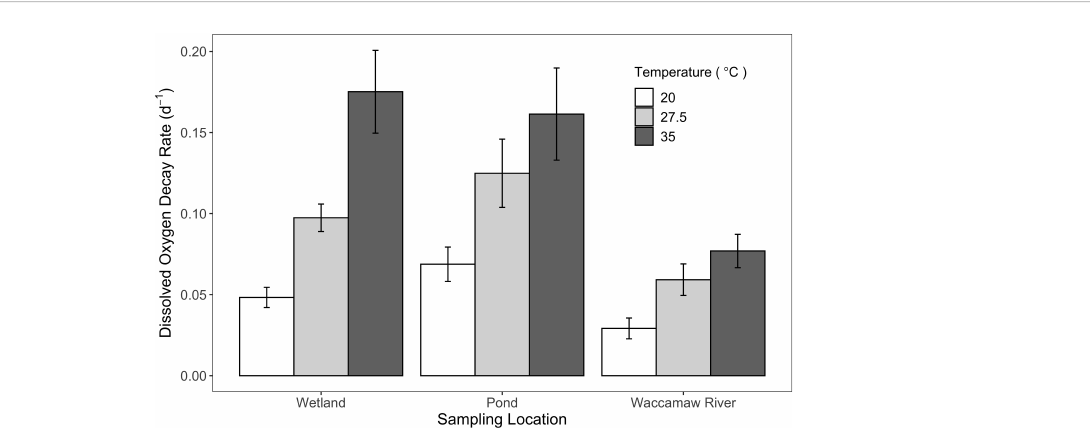
FIGURE 2 Bar plot displaying the average decay rates of dissolved oxygen (DO) (d -1 ) for each site type: forested wetland, the Waccamaw River, and stormwater detention ponds; error bars represent standard error. Plots are grouped by incubation temperature: 20 (white), 27.5 (light gray), and 35°C (dark